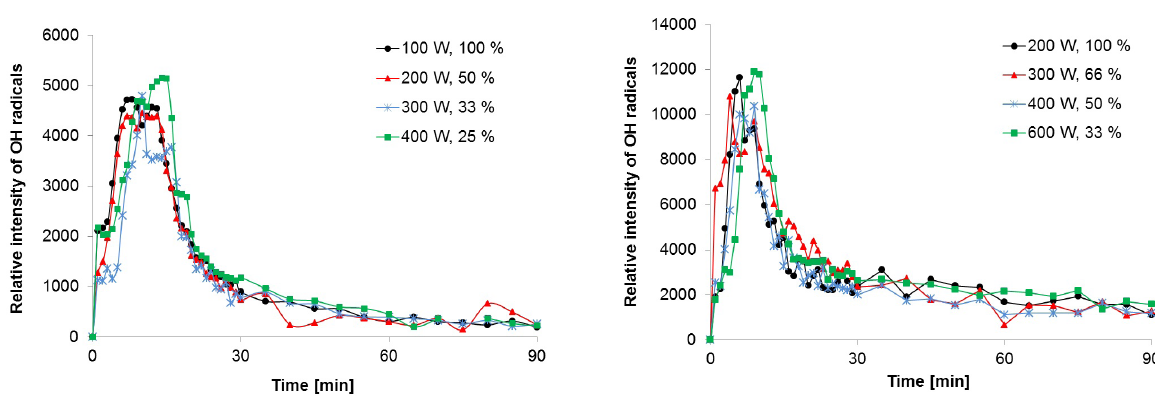
Figure 1: Time dependence of OH radical relative intensity. Samples treated at effective power 100 W (left) and samples treated at effective power of 200 W